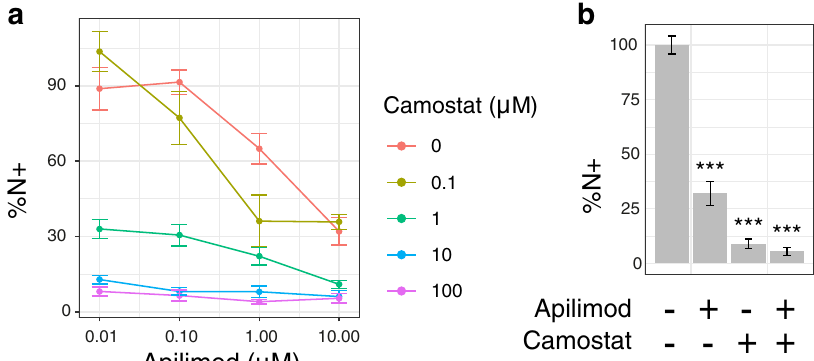
Fig. 6 Combination of Camostat and Apilimod suppresses viral entry and replication more effectively than monotherapy. a Percentage cells expressing nucleocapsid protein relative to control for Apilimod and Camostat combinations. b Percentage cells expressing nucleocapsid protein for control, Apilimod (10 µM), Camostat (100 µM) or a combination of Apilimod (10 µM) and Camostat (100 µM). Data show the mean and standard error, from three independent experiments. *** indicates p < 0.001 by two-way